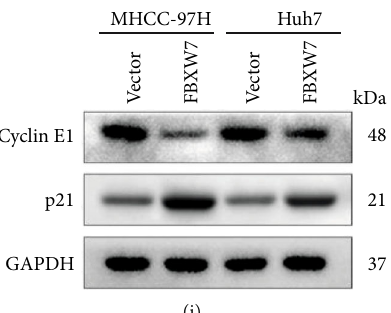
Figure 1: FBXW7 overexpression inhibits the stem cell-like properties of HCC cells. (a) FBXW7 expression was detected in spheres and their adherent HCC cells by RT-qPCR and Western blot. (b) RT-qPCR and Western blot analysis of mRNA and protein level of FBXW7 in the cell lines infected with LV-FBXW7 and LV-Vector. (c, d) CD133 surface marker expression was analyzed in the two cell lines by fl ow cytometry and IF staining. (e) Representative images and quantitative analysis of spheres. Scale bar: 100mm. (f, g) Pluripotent transcription factors, including Nanog, SOX2, OCT4, and c-Myc, were analyzed by q-PCR (f) and Western blot (g). (h) Flow cytometry showed the e ff ect of FBXW7 on the cell cycle in MHCC-97H and Huh7 cells. (i) Western blot analysis of cyclin E1 and p21 after FBXW7 alternation in MHCC-97H and Huh7 cells. Graph represents mean ± SD ; ∗ P < 0 : 05 , ∗∗ P < 0 : 01 , ∗∗∗ P < 0 : 001